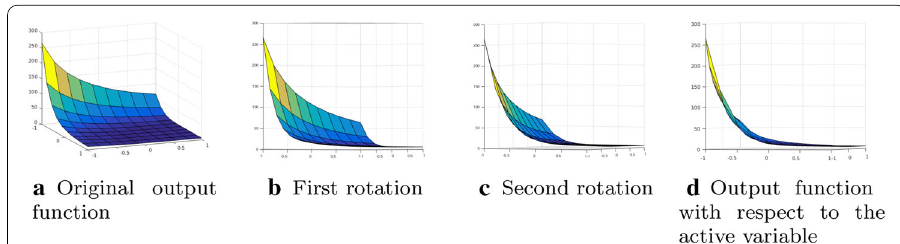
Fig. 8 Example of a bivariate output function ( a ), intermediate rotations of the domain ( b ) and ( c ), and the final state ( d ), where we can see the variation of the function along the active